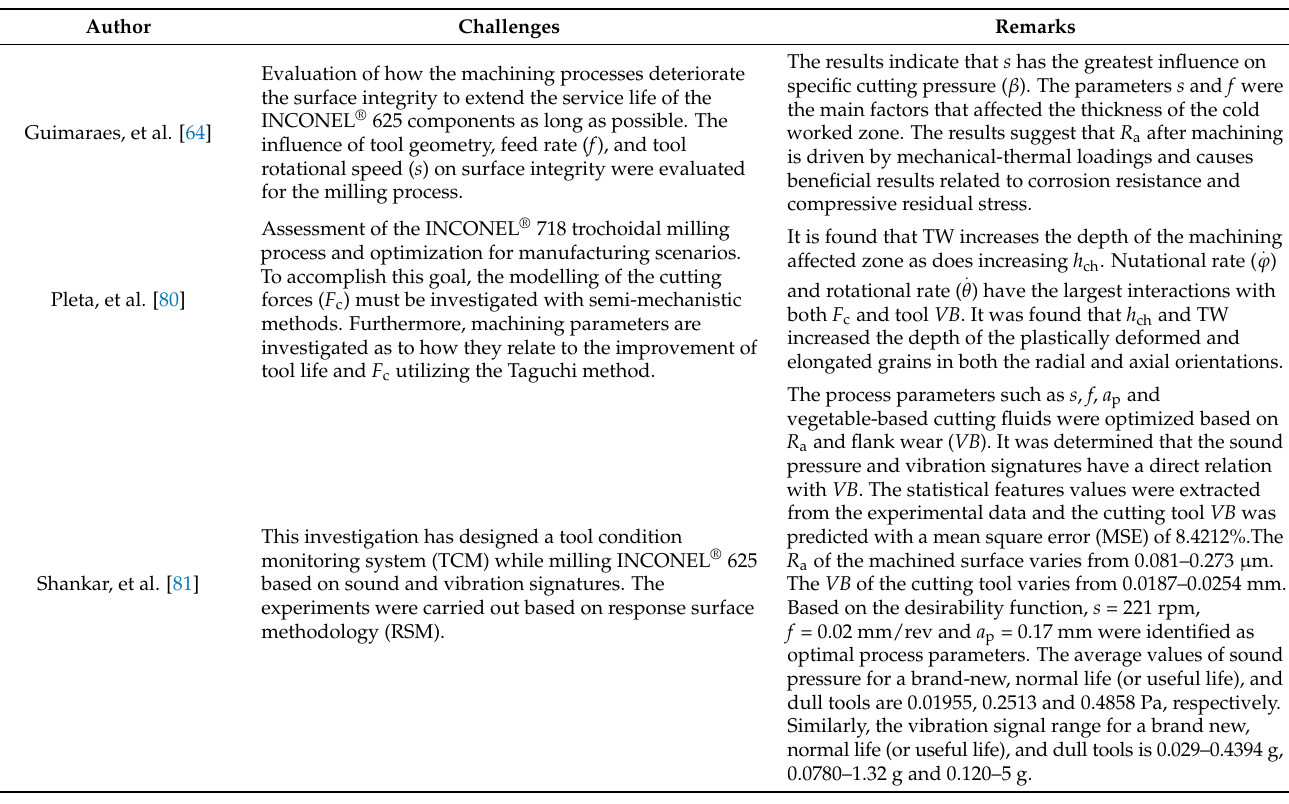
Table 6. Critical challenges and developments in the milling process of INCONEL ®